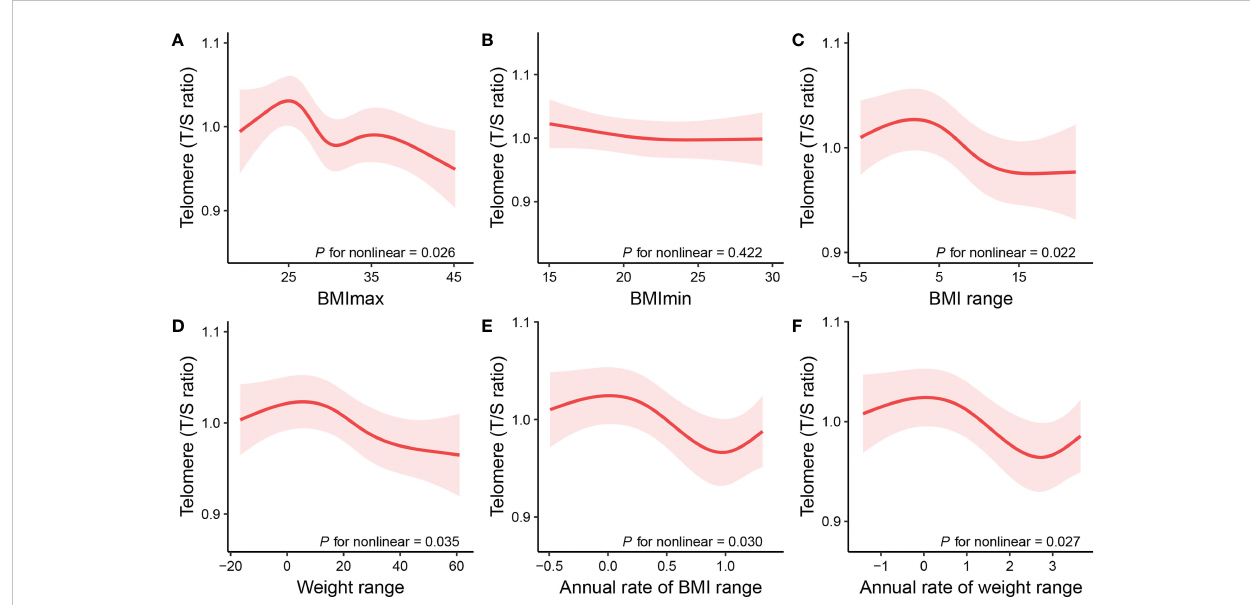
FIGURE 2 Restricted cubic spline plots of the associations of (A) BMI max , (B) BMI min , (C) BMI range, (D) weight range, (E) annual rate of BMI range, and (F) annual rate of weight range with telomere length. The associations were adjusted for age, sex, ethnicity, educational level, family PIR, alcohol use, smoking status, and medical comorbidities, including diabetes, hypertension, cardiovascular disease, chronic obstructive pulmonary disease, and cancer. BMI, body Mass Index; BMI max , the maximum of BMI; BMI min , the minimum of BMI; BMI range, the difference value between the maximum and minimum of BMI; Weight range, the difference value between the maximum and minimum of weight; Annual rate of BMI range, calculated by dividing BMI range by time; Annual rate of weight range, calculated by dividing weight range by